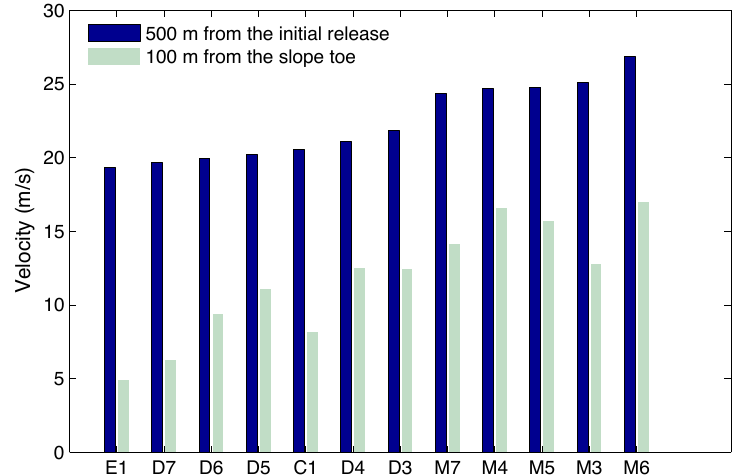
Figure 3. Velocity for all cases at two different